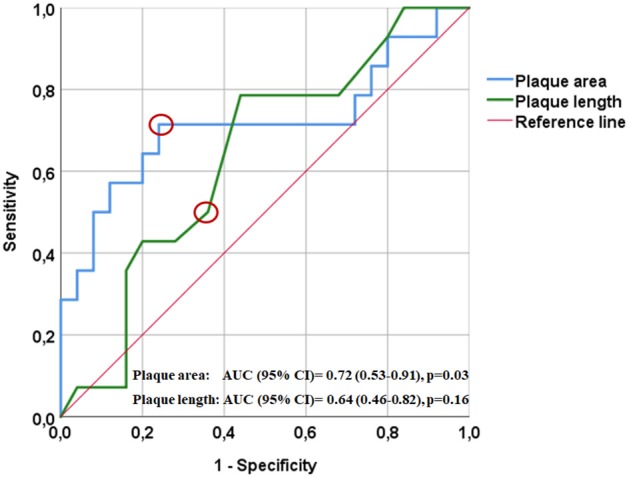
Receiver operating characteristics curve (ROC) showing the relation between plaque surface area (blue) and length (green) with ipsilateral ischemic manifestations. A cut-off plaque cross-sectional area of ≥0.36 cm2 (indicated by the red circle) yielded a sensitivity of 71% and a specificity of 76% for the development of ipsilateral manifestations; AUC (95% CI) = 0.72 (0.53–0.91), p = 0.03. A cut-off plaque length of ≥1.65 cm (indicated by the red circle) yielded a sensitivity of 50% and a specificity of 64% for the development of ipsilateral manifestations; AUC (95% CI) = 0.64 (0.46–0.82), p = 0.16.